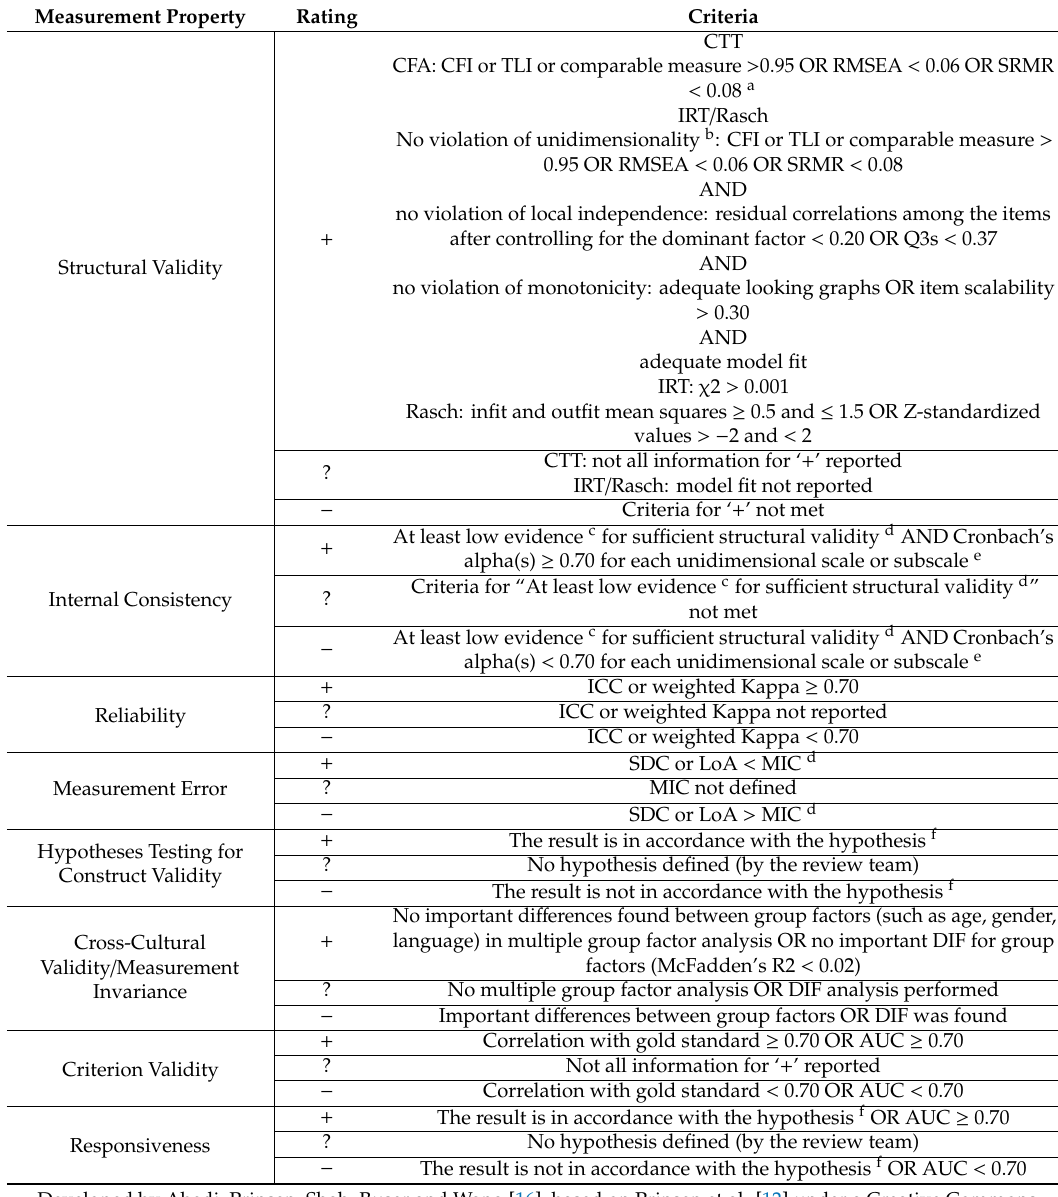
Table 1. Criteria for evaluation of the quality of